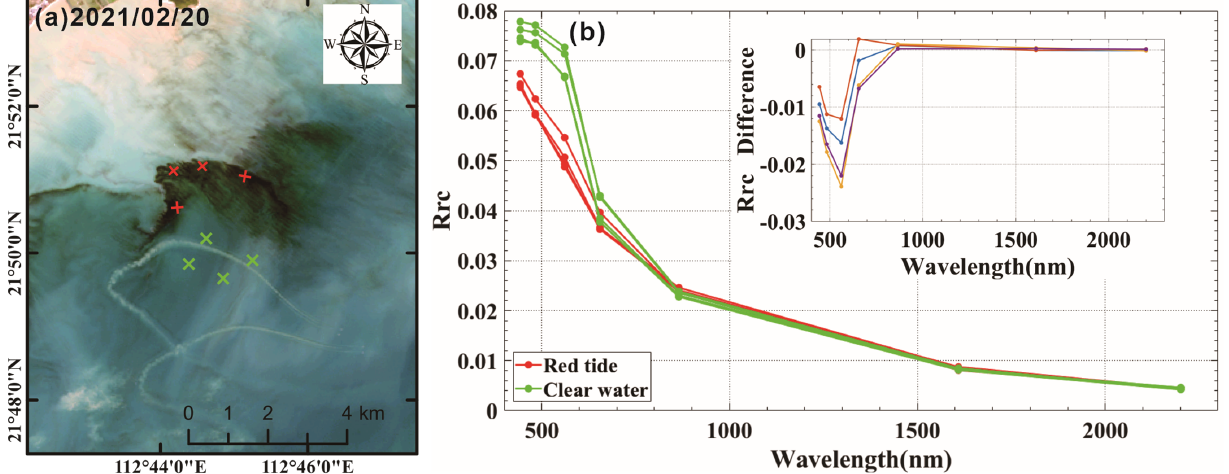
Figure 6. ( a ) Typical red tide blooms near Yangjiang; ( b ) spectral curves of selected red tide blooms and nearby water pixels marked as red and green crosses in panel a, respectively; The inset shows the Rrc difference between red tide and nearby water.